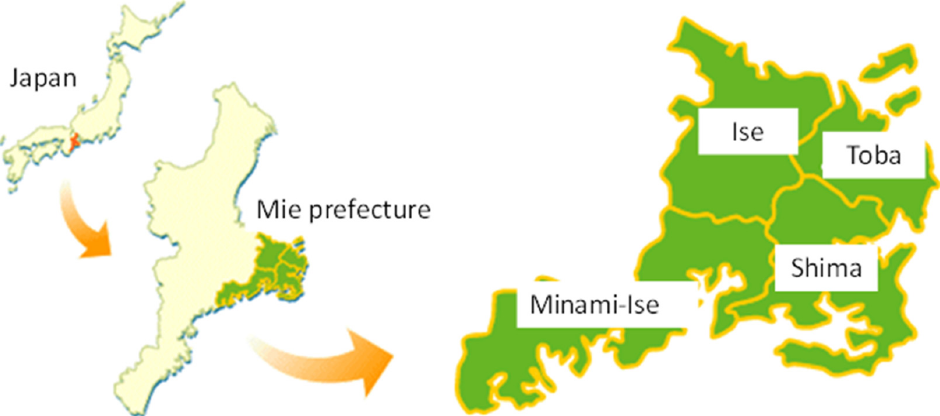
Figure 1. A map of Ise-Shima National Park: Shima city Tourism Association (https://www.kanko- shima.com/en/access.html (accessed on 27 November 2021).